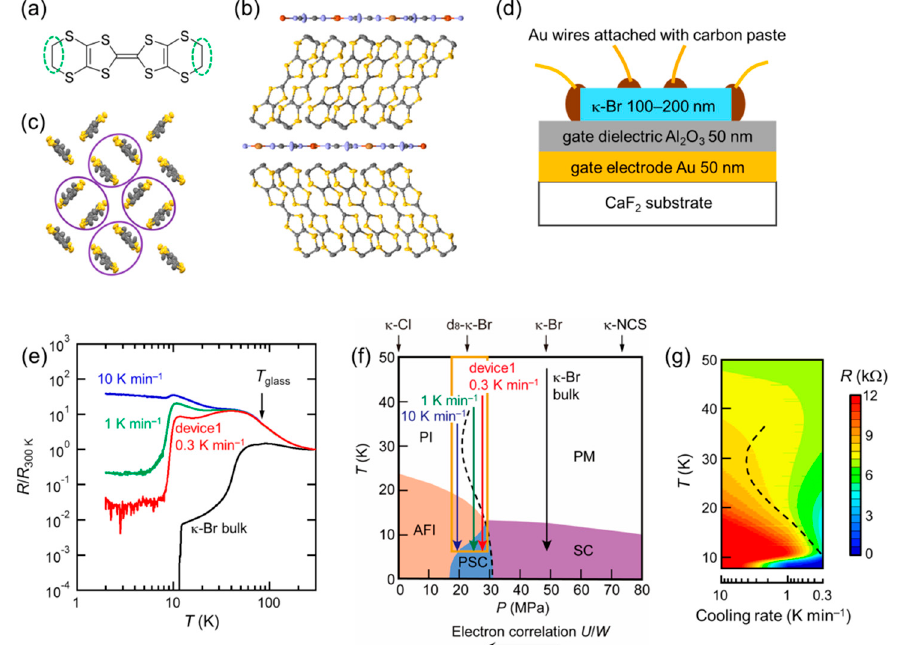
Figure 1. ( a ) BEDT-TTF molecule. The part surrounded by dotted line is terminal ethylene group. ( b ) Side view of crystal structure of κ -Br. Two-dimensional BEDT-TTF layer and insulating anion layer are alternating. ( c ) BEDT-TTF layer viewed along the long axis of BEDT-TTF molecule. Purple circle shows the dimer. ( d ) Device structure of a novel FET using κ -Br. ( e ) Temperature dependence of resistance of device1 at cooling rate of 0.3, 1, and 10 K min − 1 and bulk κ -Br. Resistance is normalized by the resistance value at 300 K for clarity. Glass transition temperature of terminal ethylene groups is shown by T glass . ( f ) P – T phase diagram of κ -BEDT-TTF salts, constructed by previous reports [3,24,25]. Bottom and top axes indicate physical pressure relative to ambient-pressure state of κ -Cl and chemical pressure by anion variation, respectively. Decreasing pressure P strengthens the electron correlation U / W , where U and W represent on-site Coulomb repulsion and bandwidth, respectively. d 8 - κ -Br represents fully deuterated κ -Br. PI, PM, AFI, SC, and PSC denote paramagnetic insulator, paramagnetic metal, antiferromagnetic insulator, superconductor, and percolative superconductor, respectively. Red, green, blue, and black arrows indicate the cooling trajectories of device1 at the cooling rate of 0.3, 1, 10 K min − 1 , and κ -Br bulk, respectively, expected from the data in Figure 1e. Orange box indicates the parameter region measured in 1e. ( g ) Color plot of resistance against cooling rate and temperature of device1 , which is comparable to the region surrounded by orange frame in Figure 1f. The S-shaped phase boundary between PI and PM seems to be reproduced as shown by broken